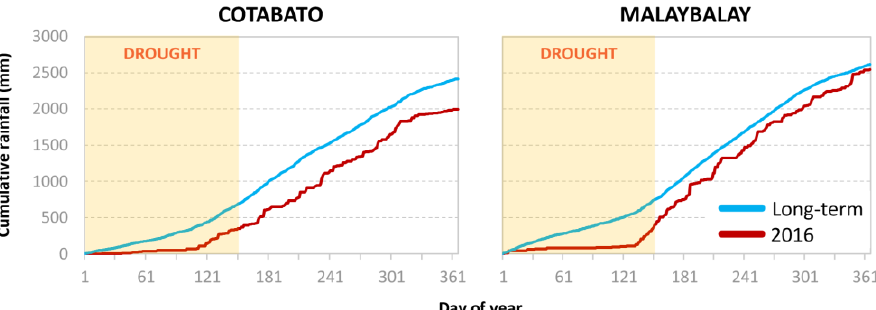
Figure 8. Comparison of 2016 and long-term (1986-2016) cumulative daily rainfall for two weather stations in Mindanao.